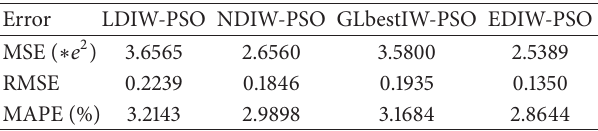
Table 3: The values of MSE, RMSE, and MAPE (%) of trained ouput by four models for the daily air quality index (AQI) of